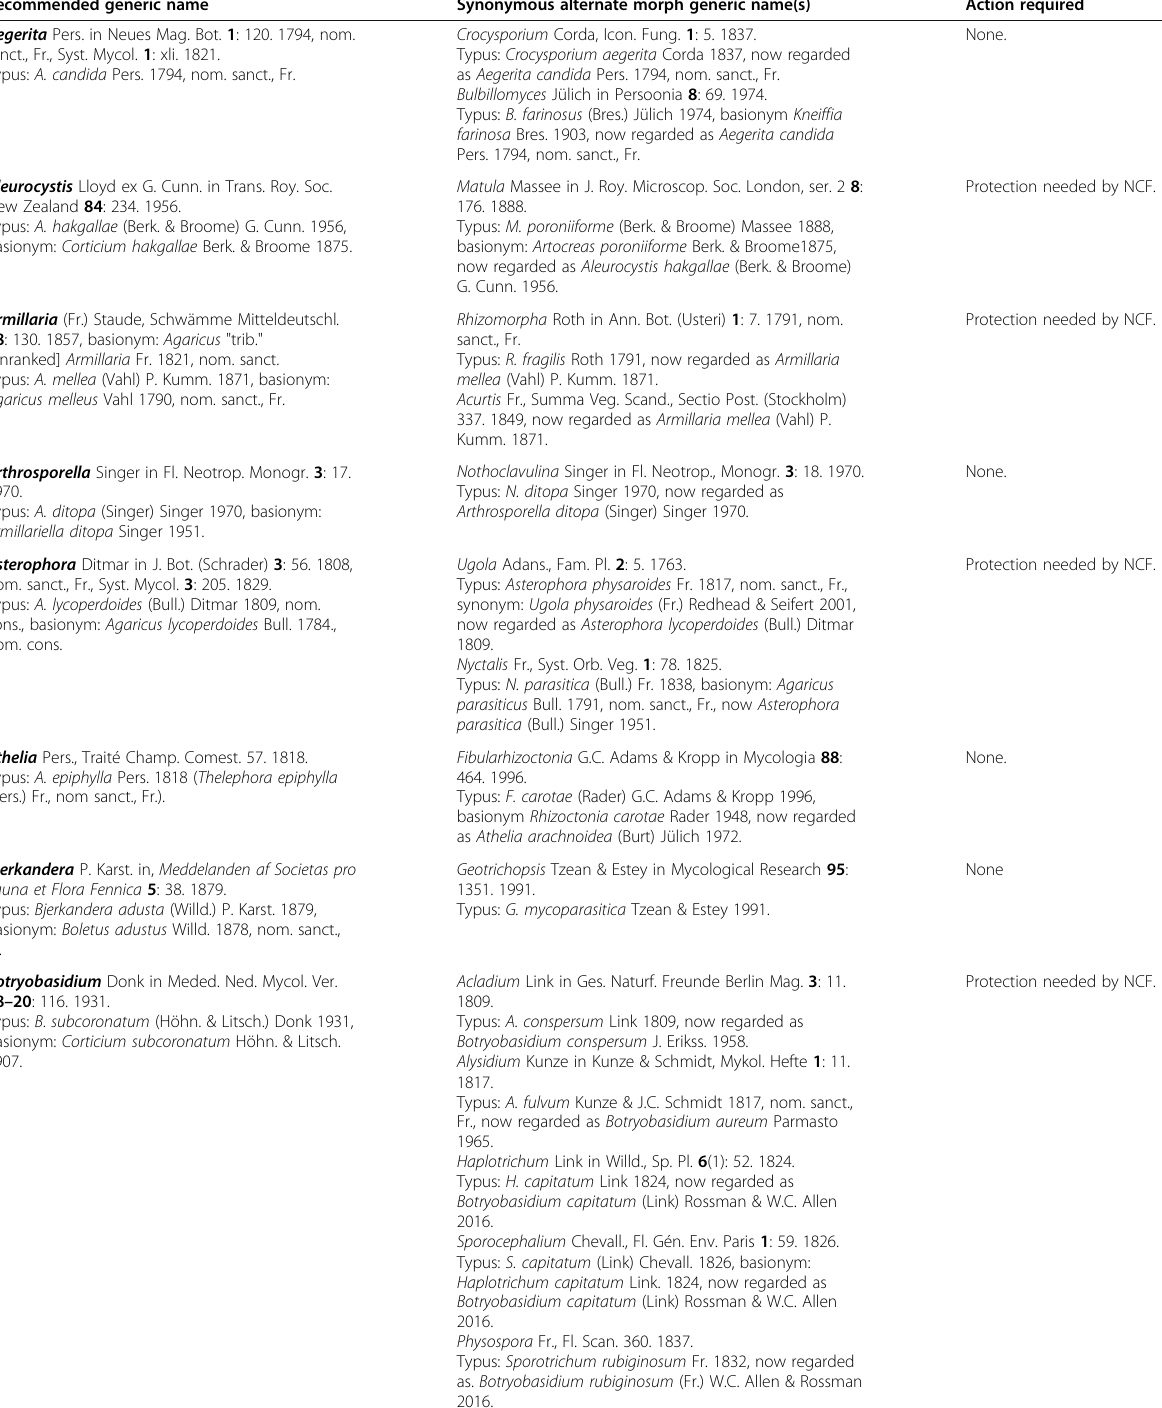
Table 1 Recommended names of genera of Agaricomycotina among those that compete for use. The recommended accepted name is in bold; see text for the rationale for these decisions. For each name this list provides the author, its date and place of publication, type, its basionym, their dates of publication and the currently accepted name, if different. The action required is indicated in the last column, specifically approval by the Nomenclature Committee for Fungi (NCF) for those generic names that do not have priority and thus need